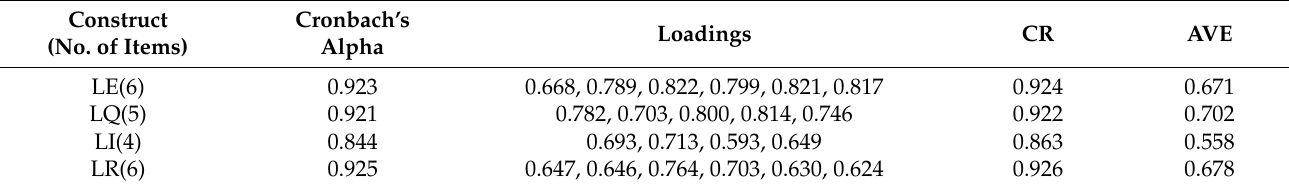
Table 3. Cronbach’s alpha, loadings, composite reliability, and AVE values.